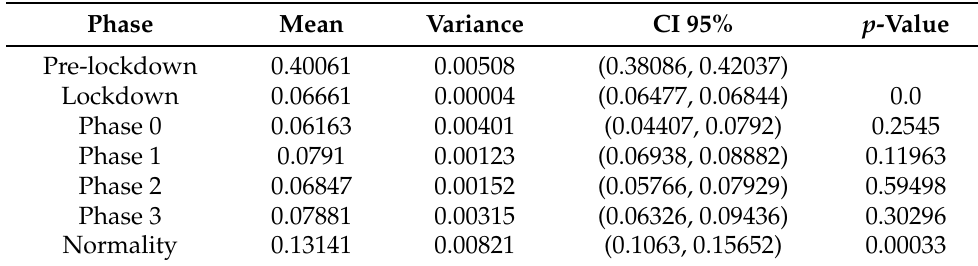
Figure 9. A distribution of the values for β for the different stages of lockdown in the different provinces of Spain. Table 4. Statistics for the Spanish Histogram